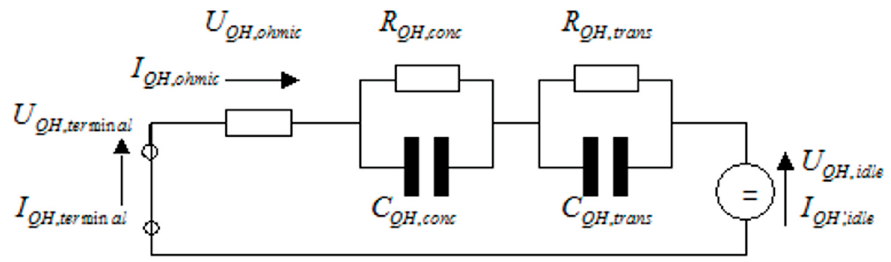
Figure 11. Substitution model of a battery cell.